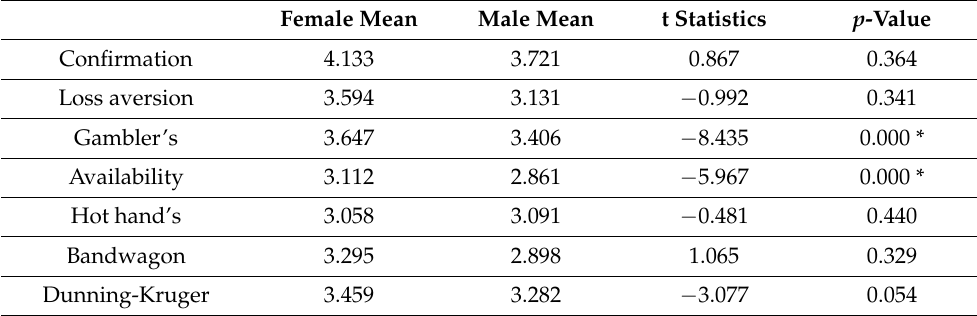
Table 1. Fallacies based on